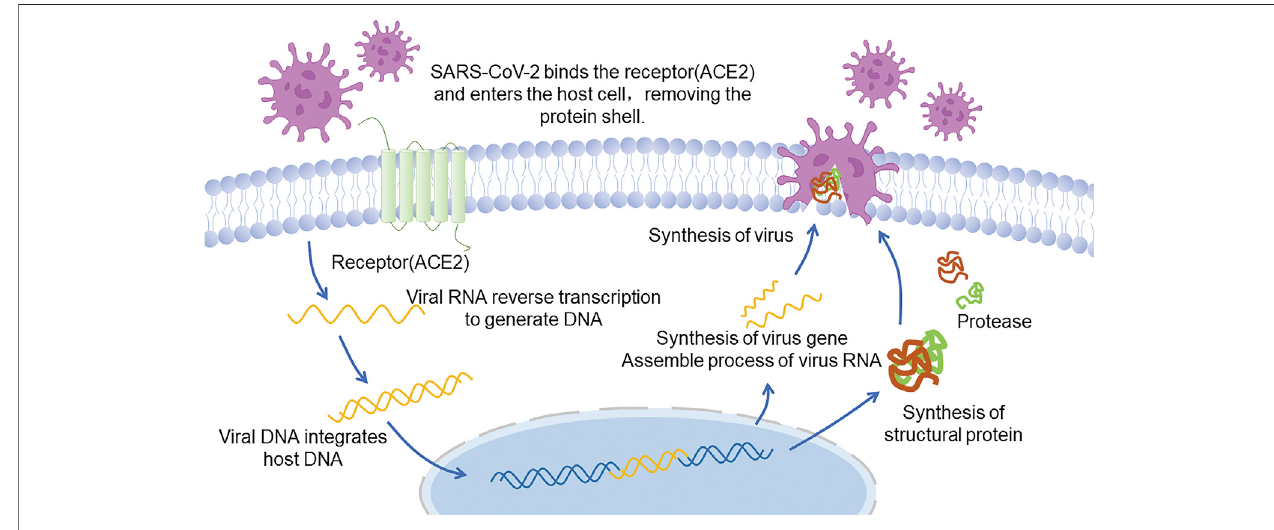
FIGURE 2 | Infection and replication process of SARS-CoV-2.